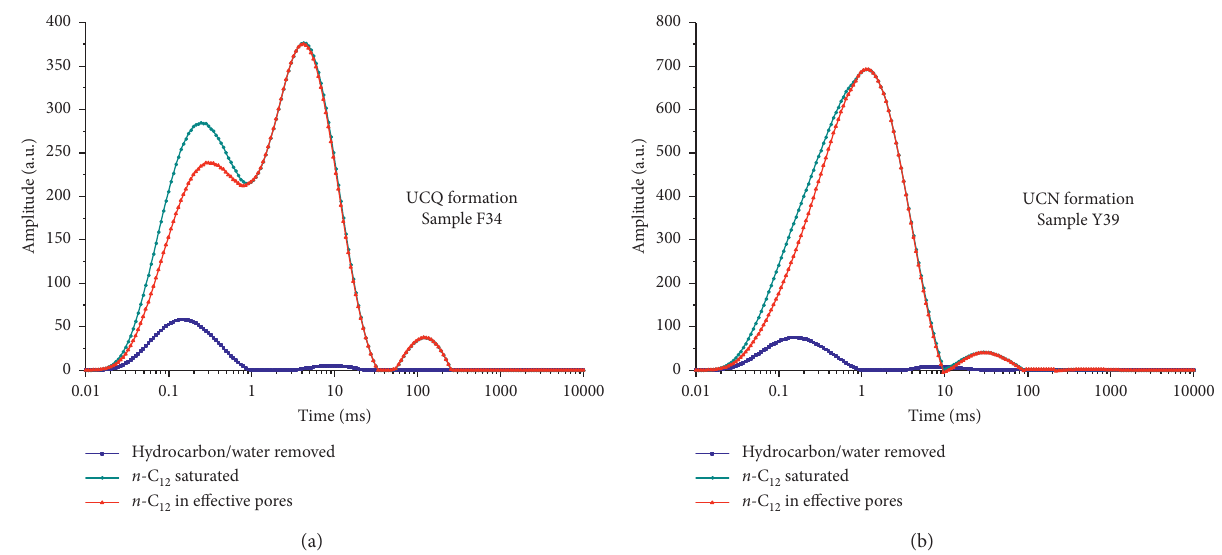
Figure 3: NMR T 2 spectra under different treatments of oil shale. UCQ, Upper Cretaceous Qingshankou (a); UCN, Upper Cretaceous Nenjiang